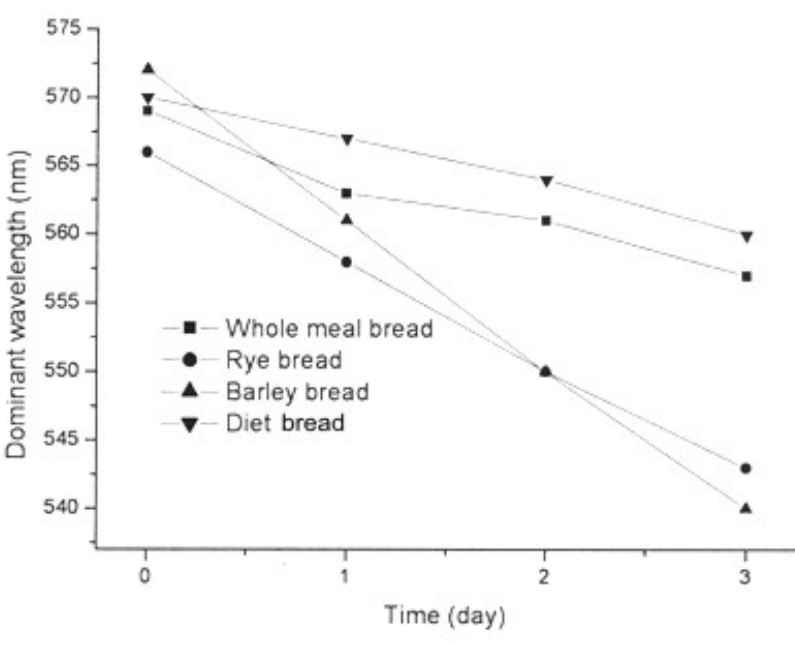
Figure 3. Dominant wavelength changes of bread